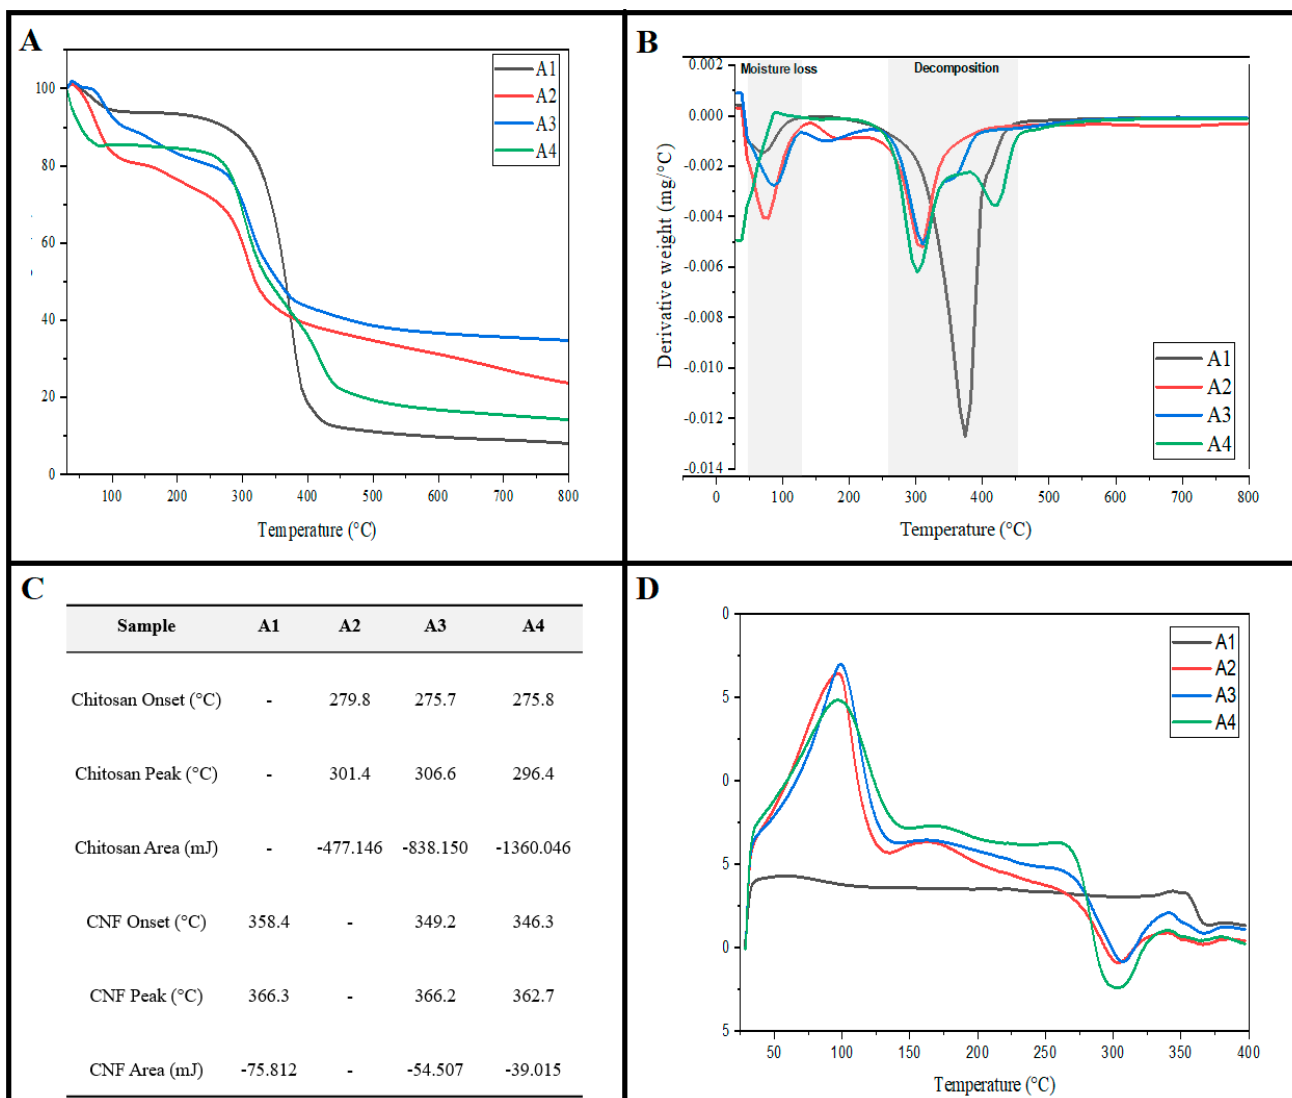
Figure 4. Thermal properties of aerogel samples: ( A ) thermo-gravimetry analysis (TGA) curves, ( B ) derivative thermo- gravimetry analysis (DTG) curves and ( C , D ) differential scanning calorimetry (DSC) analysis.